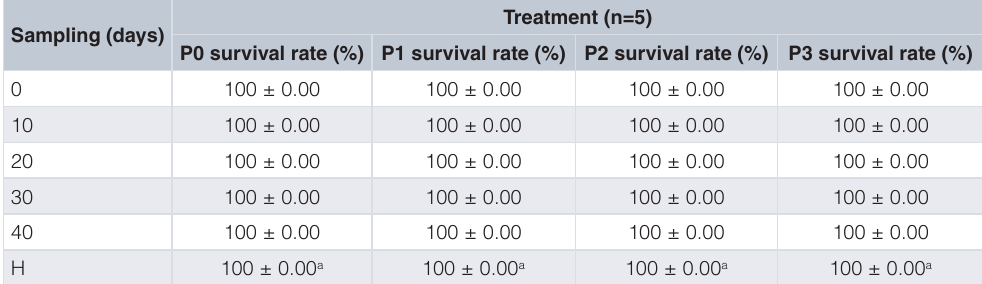
Table 5. Percentage of average survival rate (%) of female broodstock blue swimming crabs, P. pelagicus (Linnaeus, 1758), with a formulated diet of vitamin E supplementation at different doses.